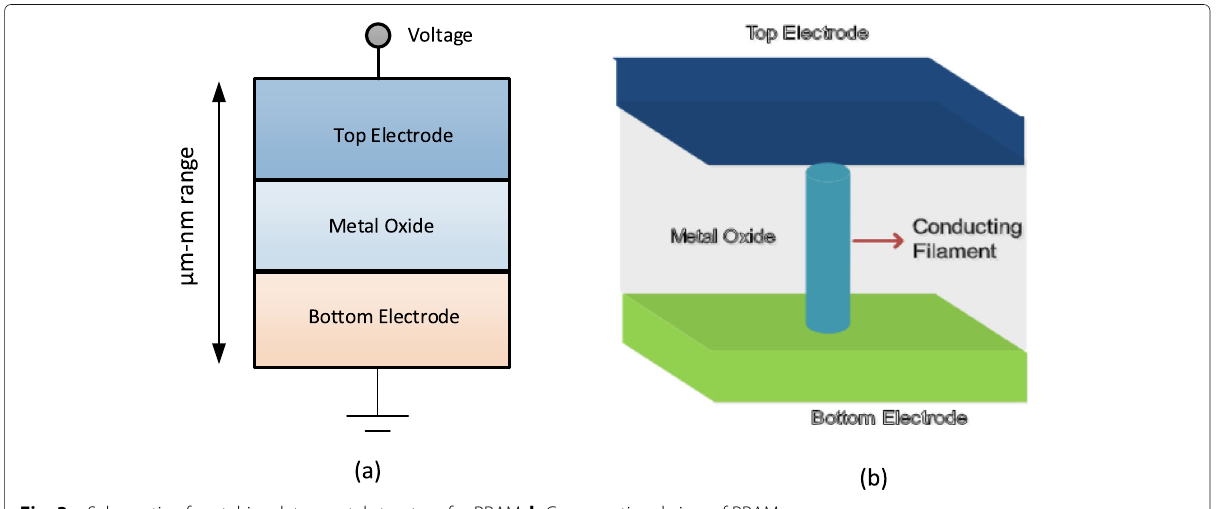
Fig. 3 a Schematic of metal-insulator-metal structure for RRAM. b Cross-sectional view of